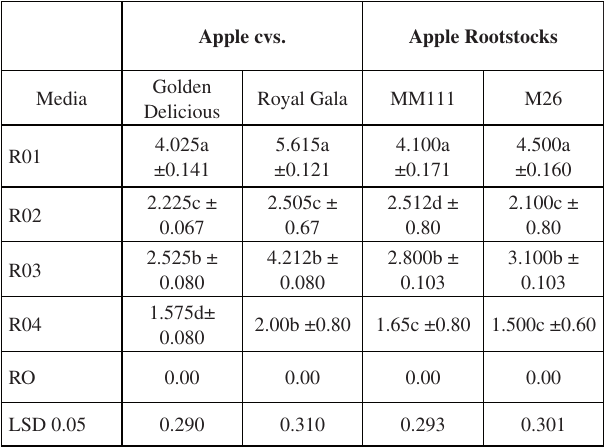
Table 2. Mean shoot number regenerated in vitro (organogenesis ability) per explants in response to the media tested for the apple cvs. and root­ stocks Apple cvs.